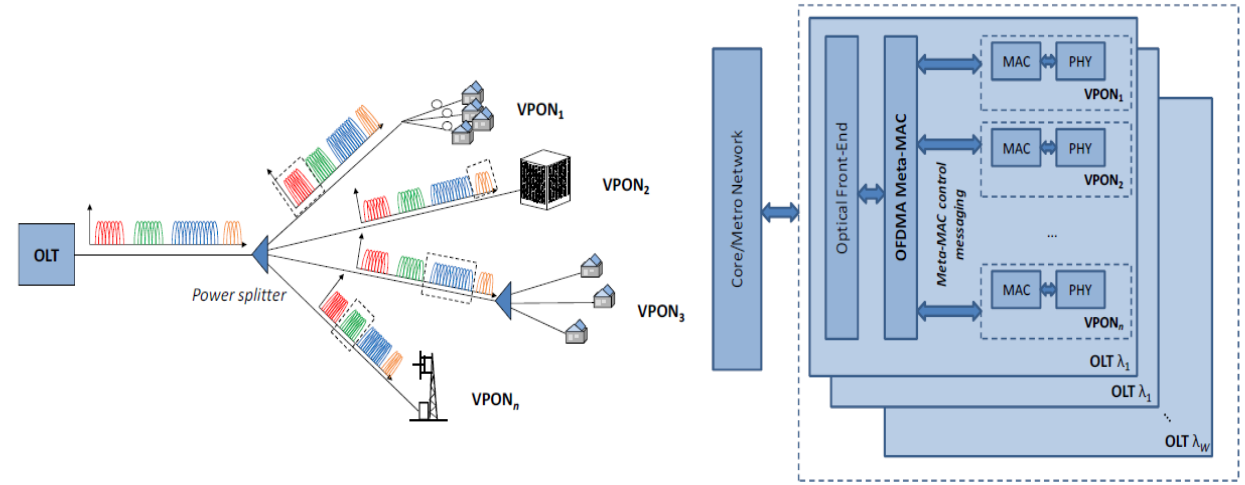
Figure 14. An architectural example of OFDM-PON along with its proposed meta-MAC scheme for dynamic resource provisioning [49].